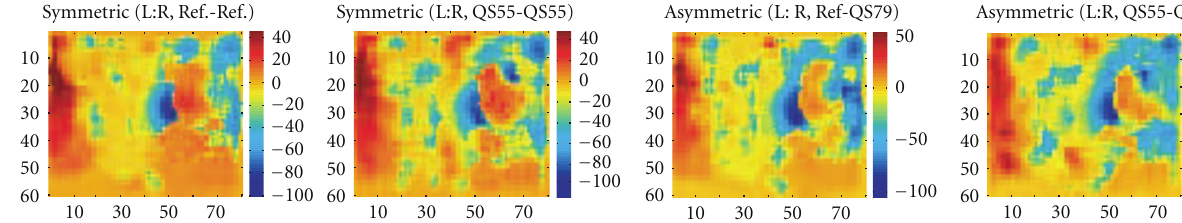
Figure 9: Car and Cattle images and its depth maps with di ff erent block sizes and searching area ± 128. Symmetric (L:R, Ref.-Ref.)